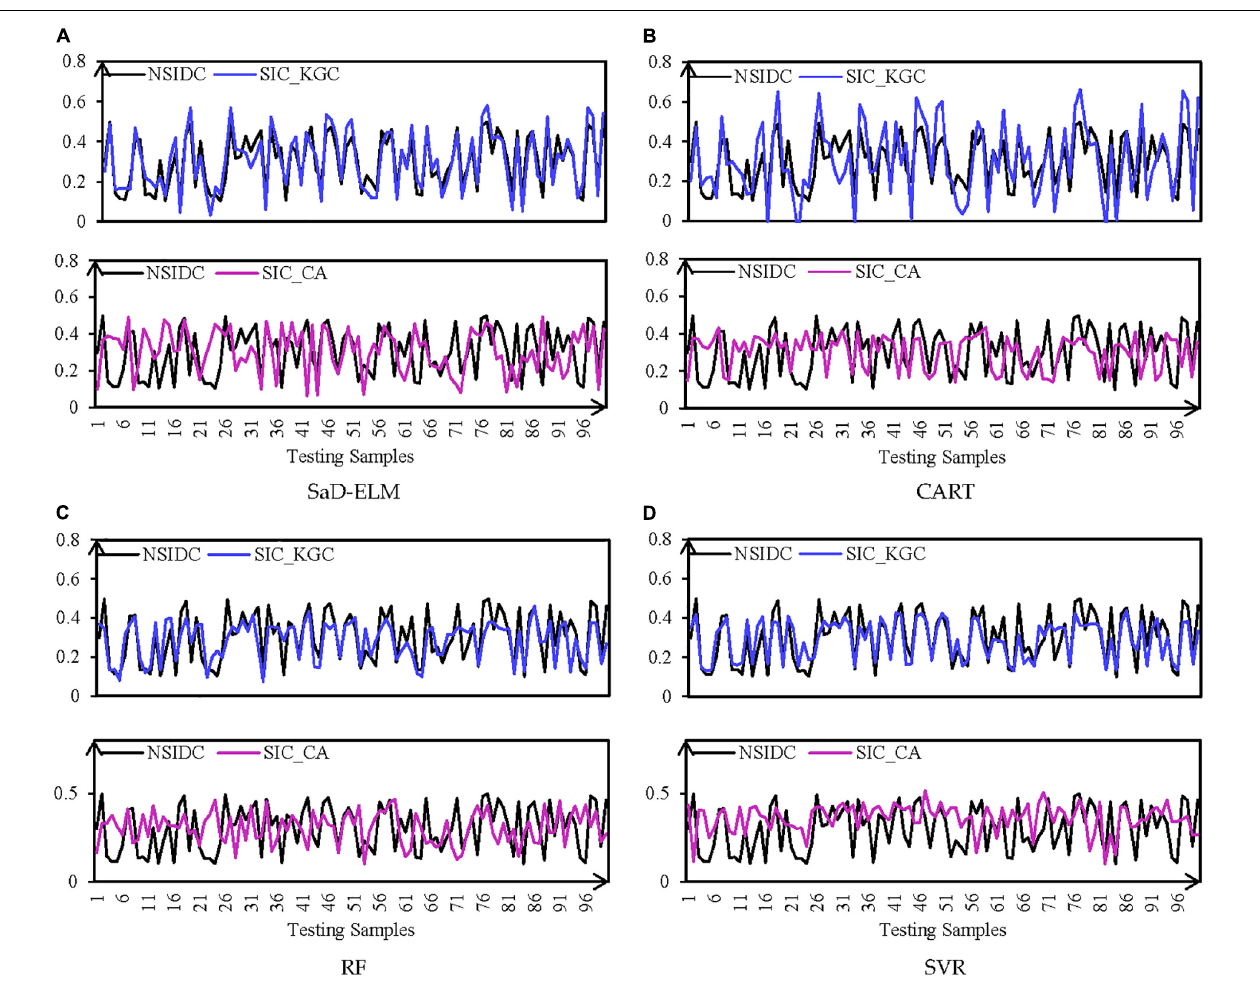
FIGURE 4 | Mean prediction with lead time = 1 day of (A) SaD-ELM, (B) CART, (C) RF, and (D) SVR. The black line represents the observed SIC of NISIDC; the blue line represents the prediction based on causal analysis; and the red line represents the prediction based on correlation